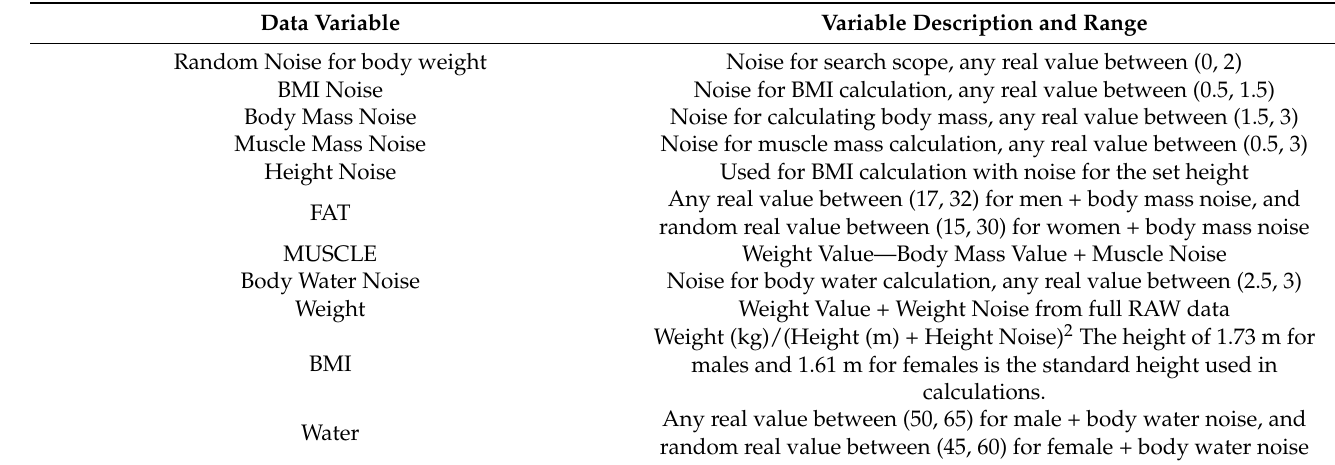
Table 1. Description of the noise of each variable set to calculate different variables.